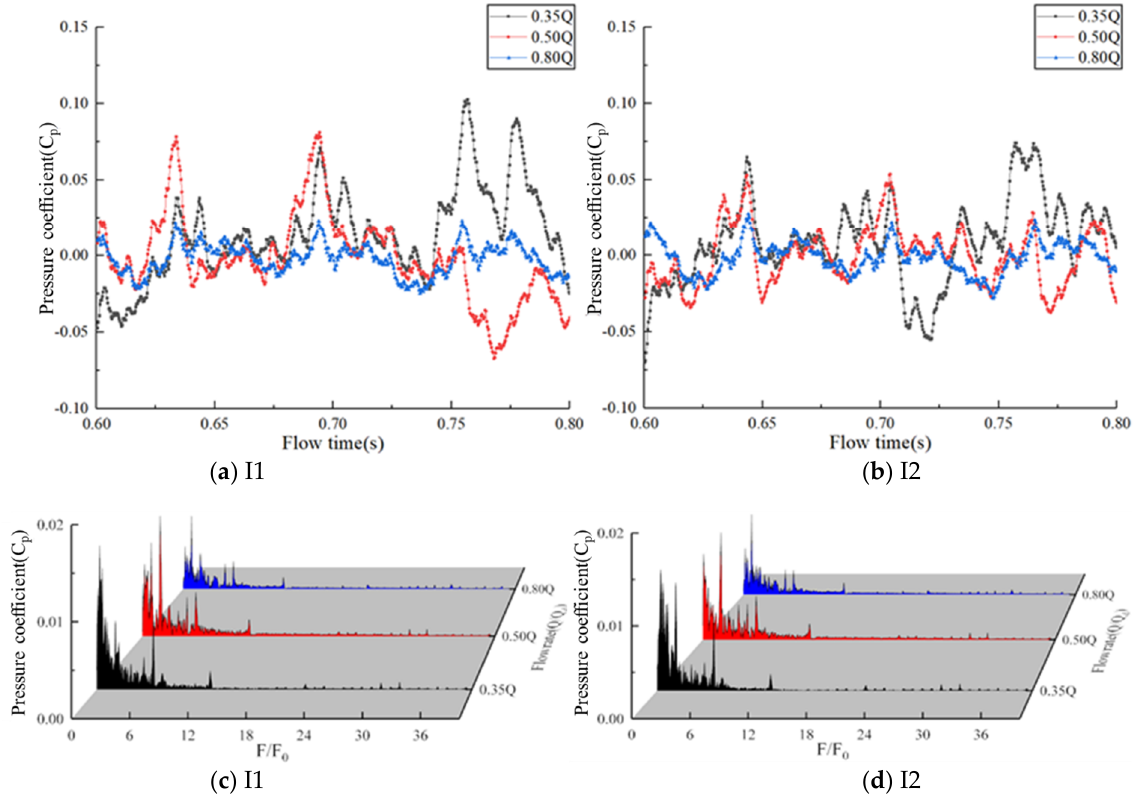
=4   ) at the inlet of impeller. 1